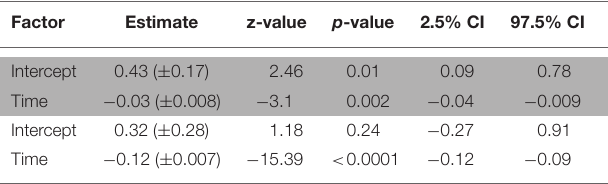
TABLE 5 | Time effect on sperm viability, determined by a generalized linear mixed model for the blind standard experiment in Drosophila melanogaster (area highlighted in gray, n =